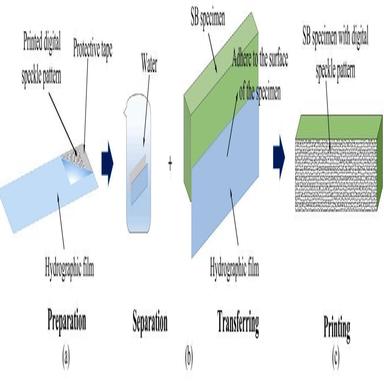
The procedure of the fabrication for the digital speckle pattern based on the WTP technique.